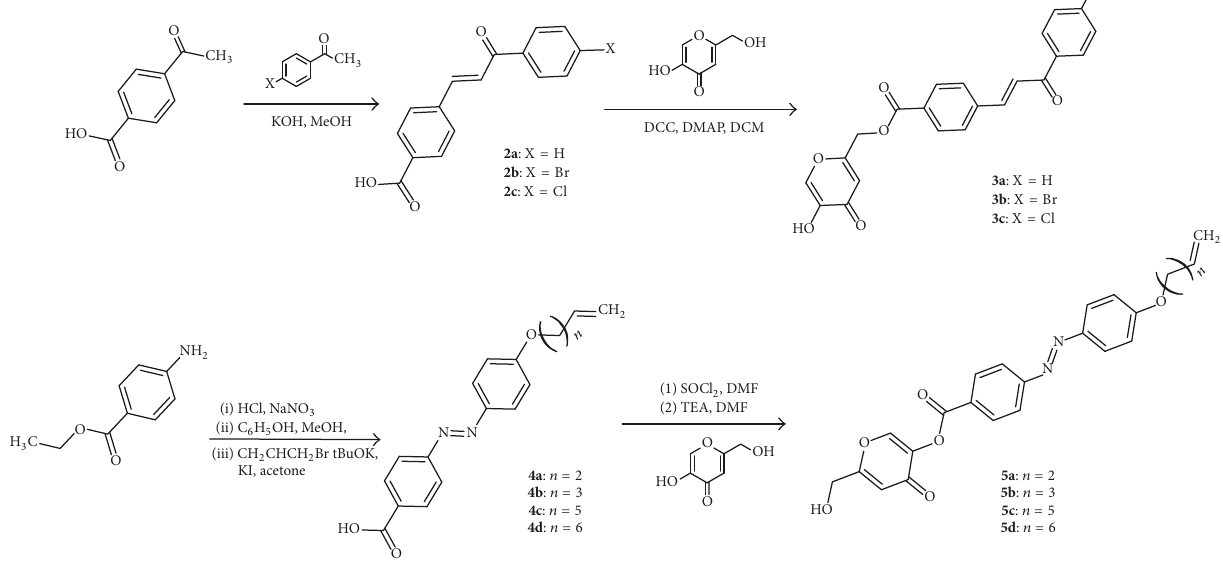
Scheme 1: Synthesis of kojic esters (3a–c) and (5a–d) .